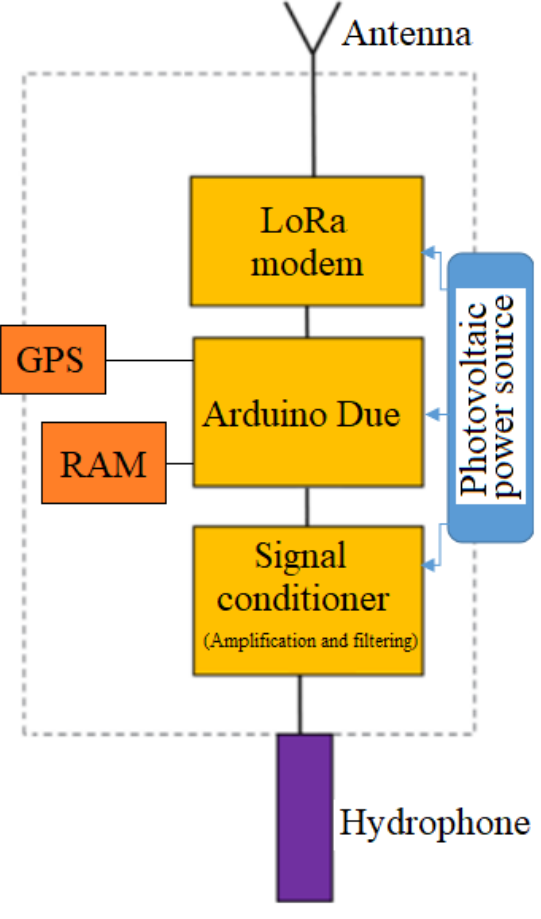
Figure 1. Block diagram of an underwater noise monitoring beacon.